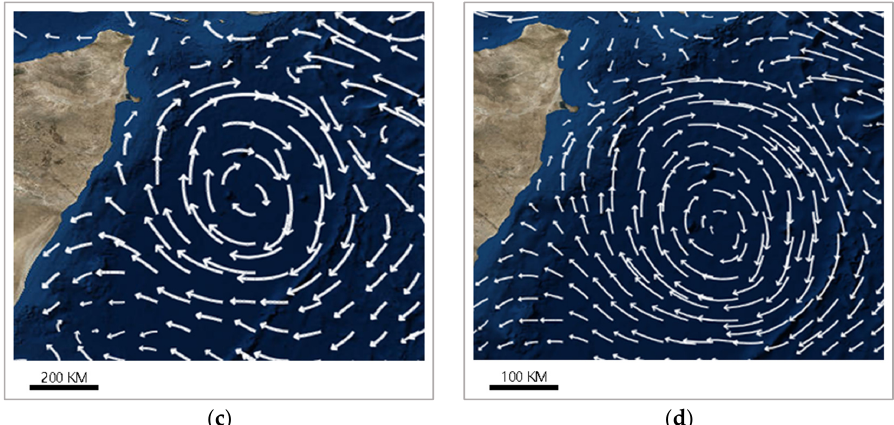
Figure 8. ( a ) is an eddy current representation at 1:500,000 scale, and ( b ) is an eddy current representation at 1:300,000 scale, ( c ) is an eddy current representation at 1:200,000 scale, and ( d ) is an eddy current representation at 1:100,000 scale. Figure 9 is the flow field eddy current effect diagrams for direct flow visualization method, geometric flow visualization method, and multi-scale flow field mapping method based on real-time feature streamlines.